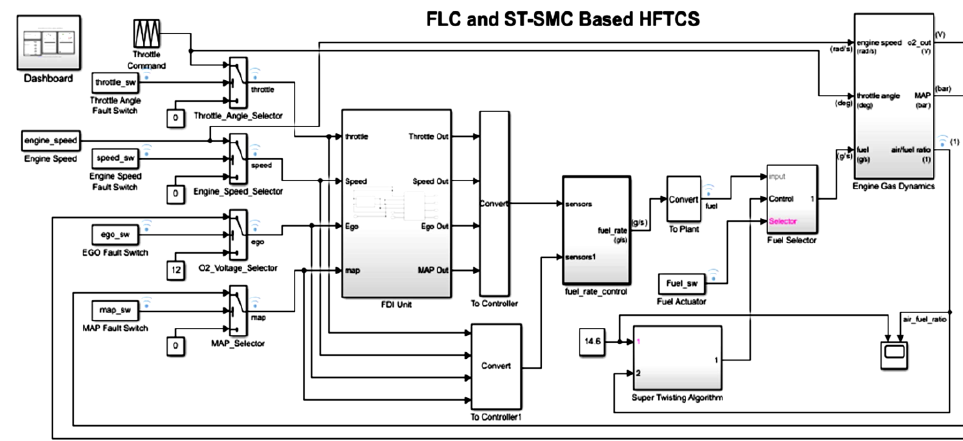
Figure 15. Matlab diagram of proposed HFTCS.